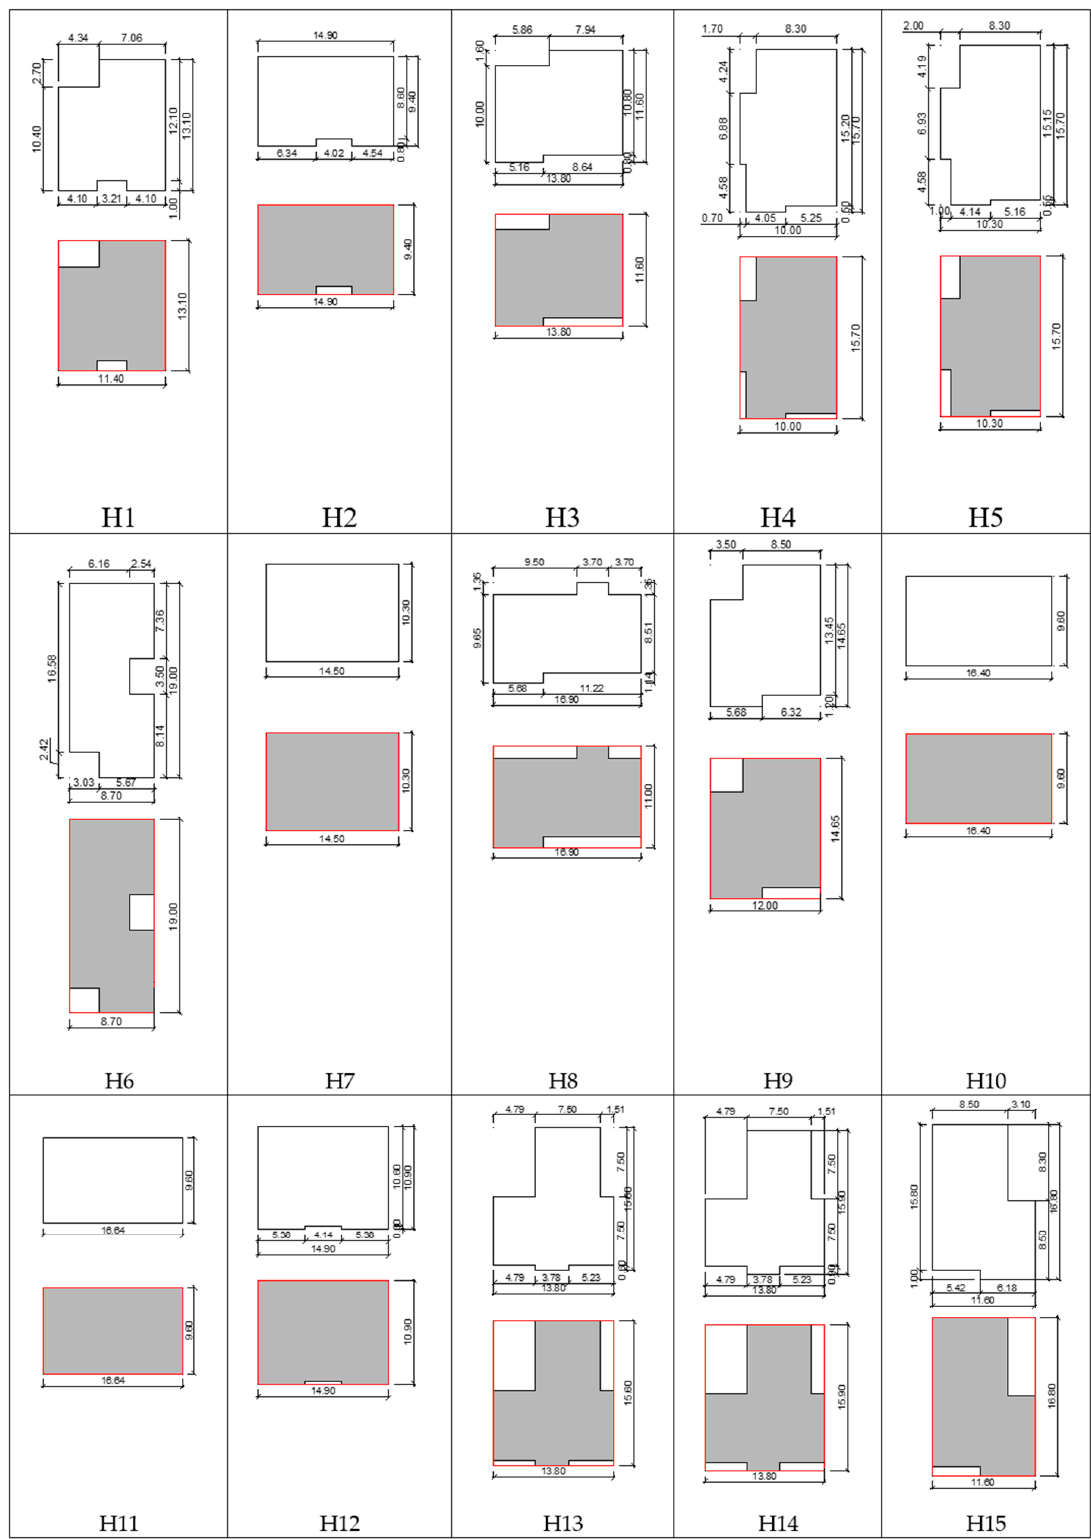
Figure A1. Building plans of the H1–H15 set and rectangles described on rectangular polygons of the plans of these buildings.